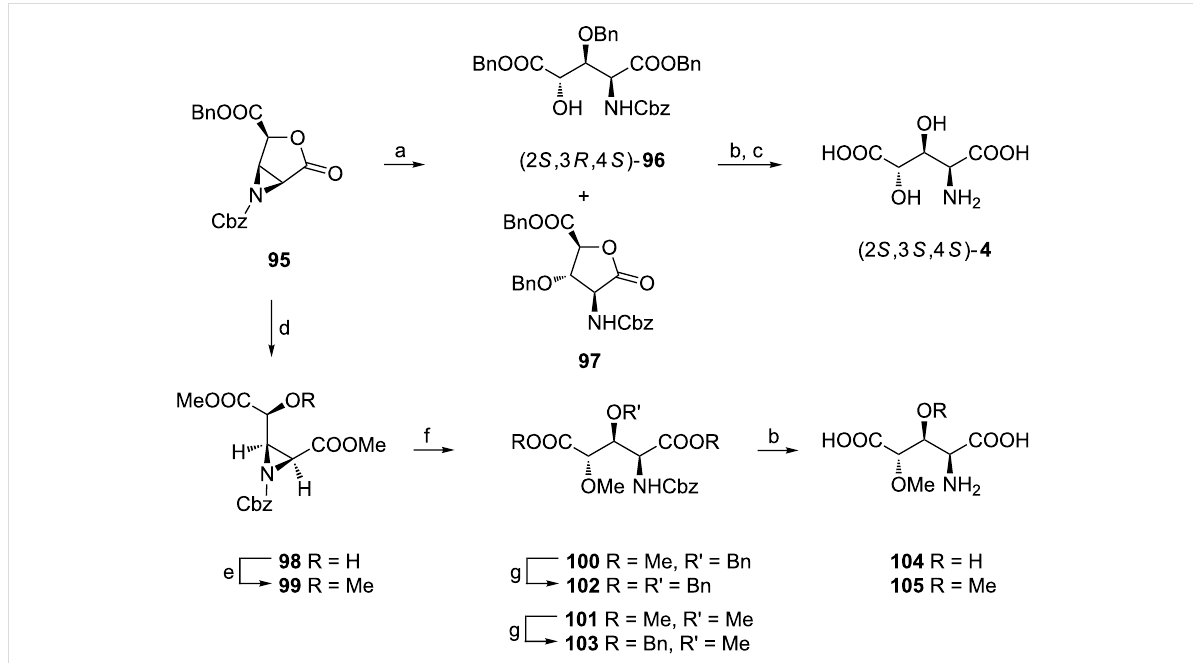
Scheme 25: Synthesis of (2 S ,3 S ,4 S )- 4 from the aziridinolactone 95 . Reagents and conditions: a) BnOH, BF 3 · OEt 2 , CHCl 3 ; b) H 2 , 10% Pd/C, MeOH, then MeOH, H 2 O; c) HO – resin AG1-X4; d) MeOH, BF 3 · OEt 2 ; e) MeI, Ag 2 O, CaSO 4 , THF; f) BnOH or MeOH, BF 3 · OEt 2 ; g) Ti(OBn) 4 , BnOH,